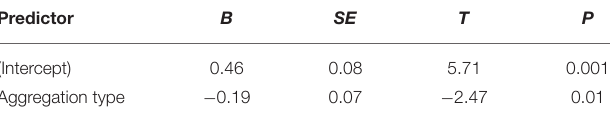
TABLE 2 | Parameter estimates in the linear mixed model for landscape preference rating as a function of aggregation type. Predictor